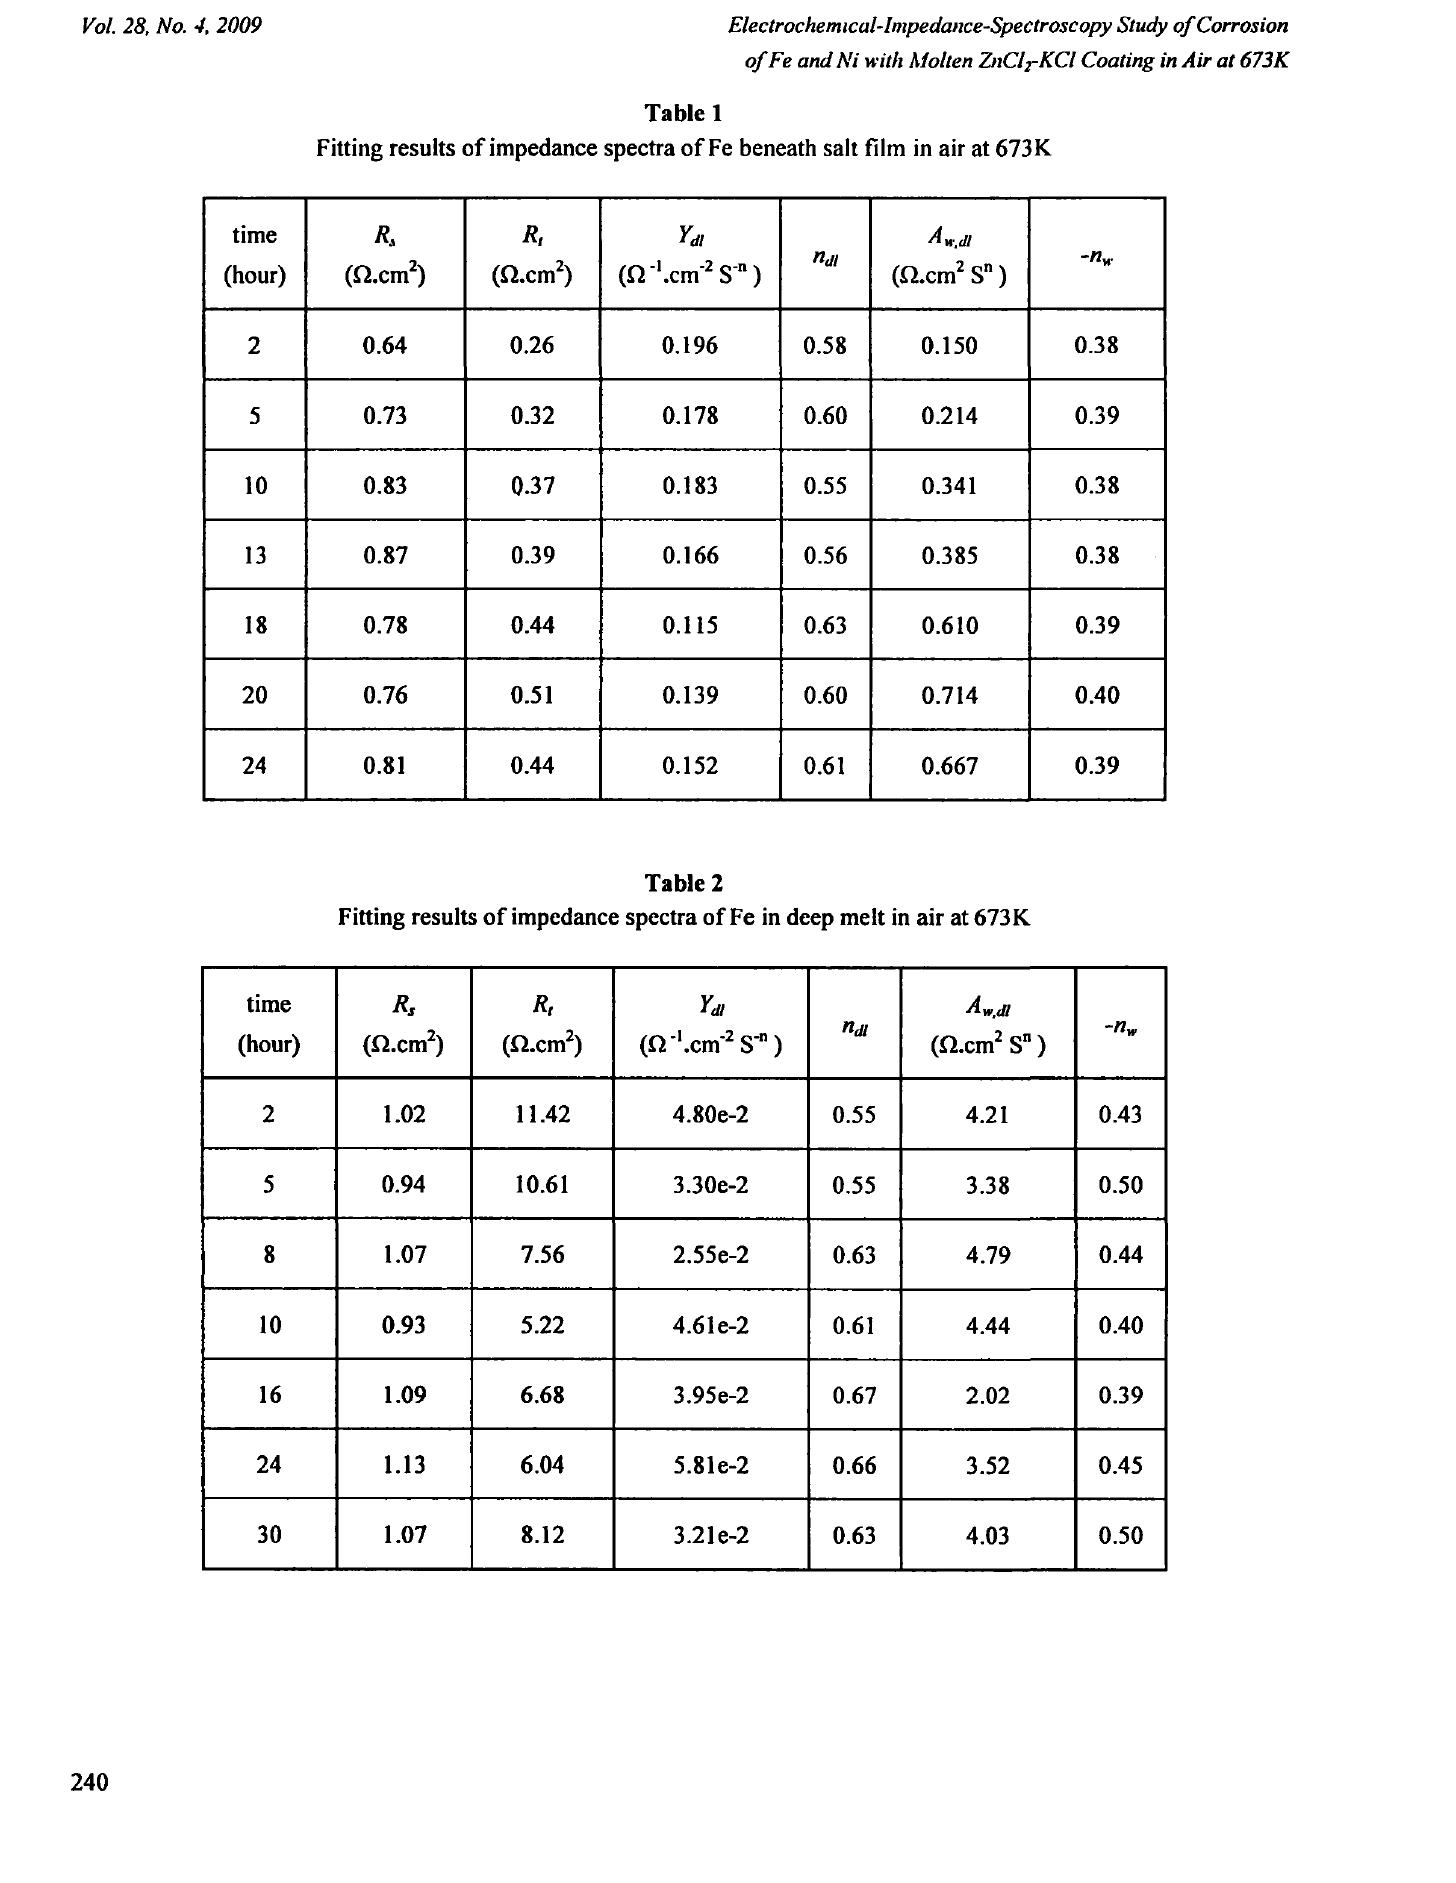
Fitting results of impedance spectra of Fe in deep melt in air at